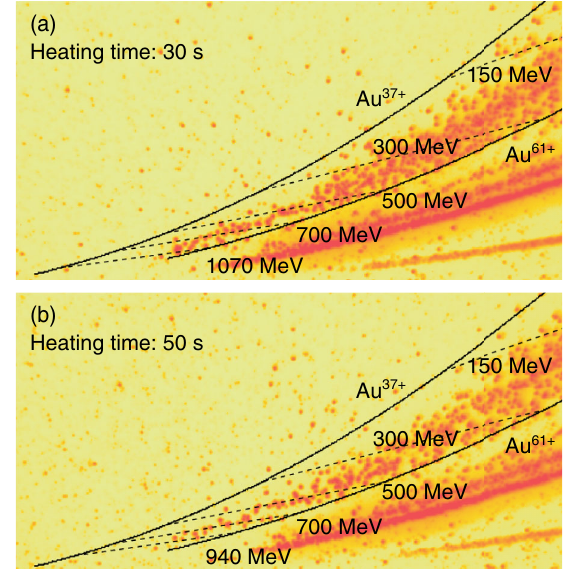
FIG. 4. Raw data measured with TPS from double-layer Au targets ( 60 μ m CNF þ 150 nm Au) varying heating time of 30 s (a) and 50 s (b).